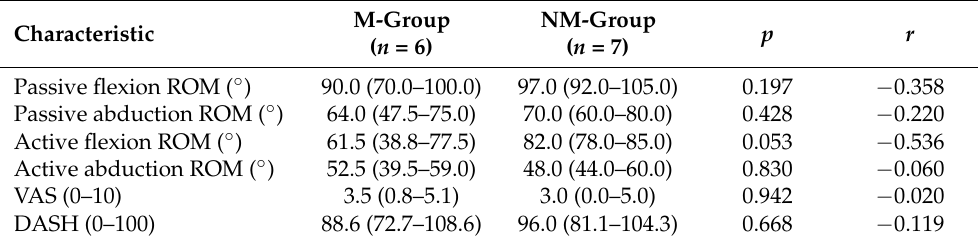
Table 2. Baseline active and passive range of motion (ROM) of shoulder flexion and abduction, visual analogue scale (VAS) ratings for pain levels, and Disabilities of the Arm, Shoulder and Hand (DASH) scores. Values are presented as median and interquartile percentages for each of the two groups: the non-manipulated feedback treatment group (NM-group) and the manipulated feedback treatment group (M-group).